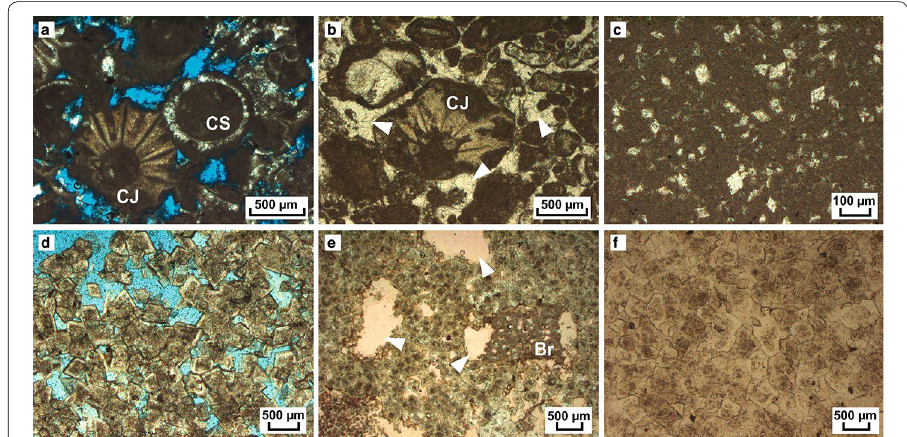
Fig. 7 Thin sections of Jurassic carbonate rocks from the Dingolfing FB rock core. a Fossiliferous grainstone of Malm ζ 4–5 section containing peloids and abundant fragments of green algae Clypeina jurassica (CJ) and Campbelliella striata (CS). Note interparticle porosity (blue staining) cumulating to φ w eff of 13.0% for the whole sample. b Same rock type and strata than in a but pore space is reduced by sparitic cementation (arrows) between particles. ( φ w eff = 1.7% ) . c Euhedral dolomite crystals floating almost isolated in a microcrystalline calcite matrix of a dolomitic wackestone (Malm ζ 4–5). No porosity is visible in this thin section but φ w eff of sample is 2.4%. d Idiotopic dolostone (medium crystalline) with abundant intercrystal porosity (Malm ζ 4–5) reaching φ w eff of 16.3%. e Hypidiotopic dolostone (medium crystalline) showing some intercrystal and vuggy porosity (arrows) of dissolved fossil fragments. Fragment of a bryozoan (Br) is still preserved in one of the vugs ( φ w eff 8.6%, Malm ζ 1). f Xenotopic (non-rhombic) dolostone with sutures along contacts of coarse dolomite = crystals (Malm δ). Due to complete dolomitization and compaction, pore space is highly reduced in this sample ( φ w eff =